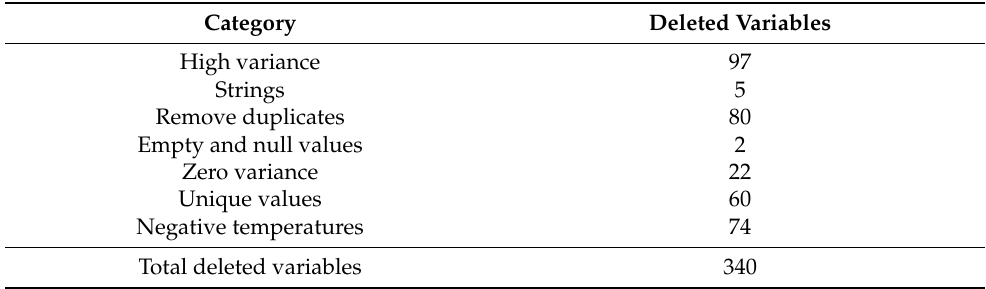
Table 2. Amount of variables eliminated in each of the categories after performing the data clean- ing